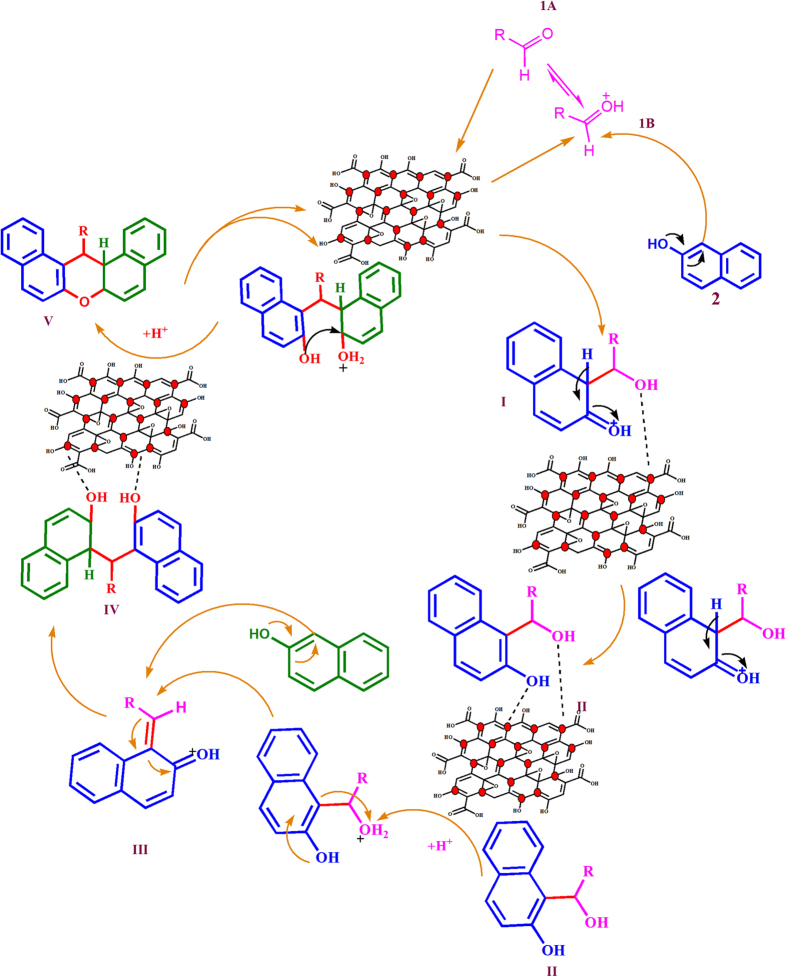
Plausible mechanism for the synthesis of xanthenes catalyzed by GO-CuFe2O4 nanocomposite.